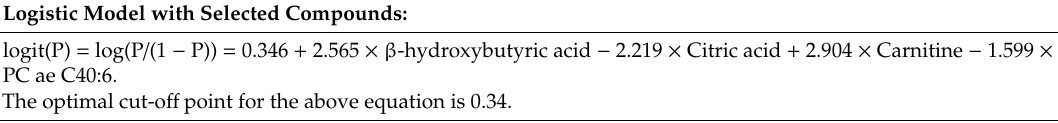
validation set are colored in red. from the